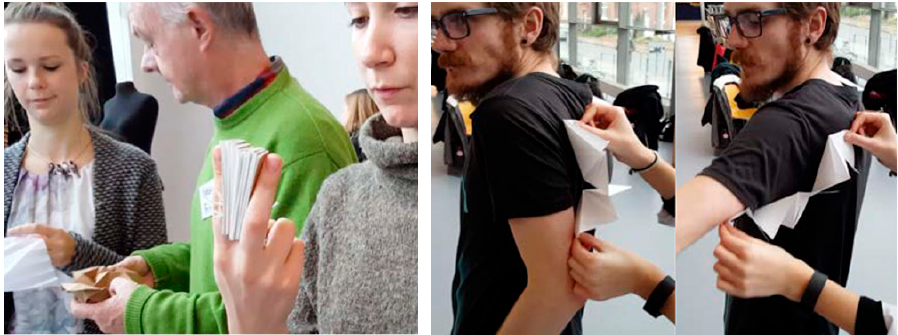
Figure 4. Loom 2 probe-set (1): Embodied Paper Prototypes.